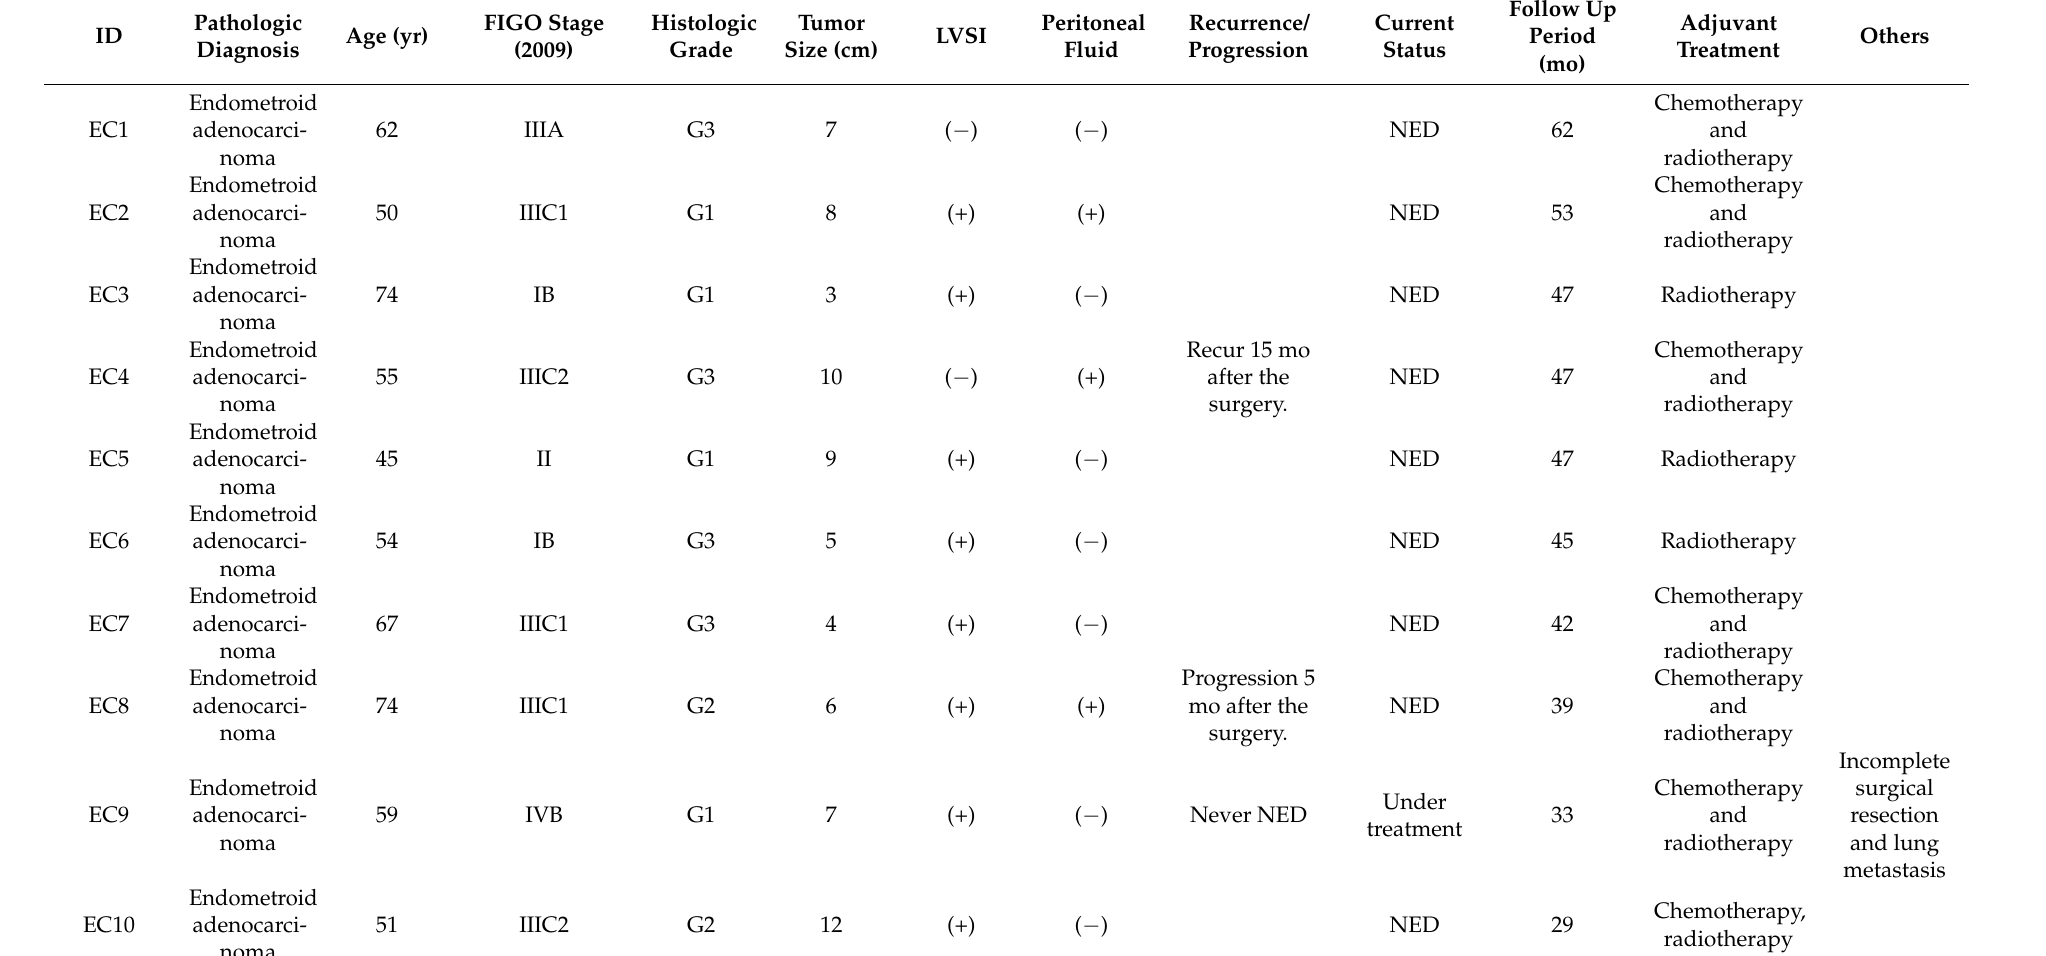
Table 1. Clinical information of the 10 patients with endometrial